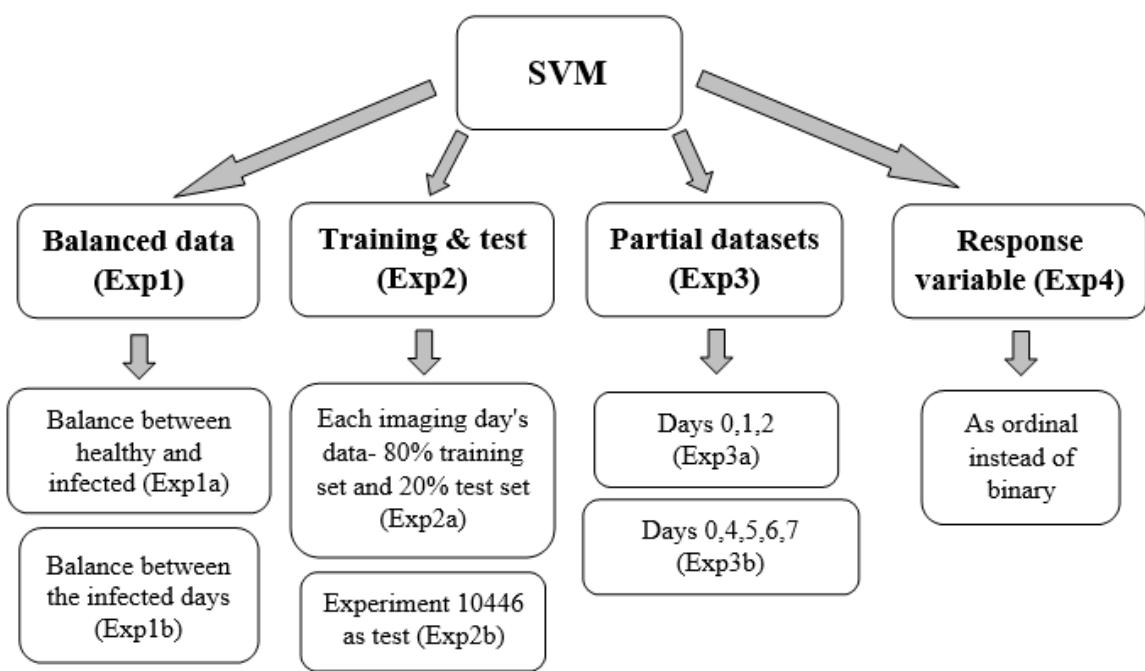
Figure 4. Diagram representing the logical flow of the different analyses . Exp1.